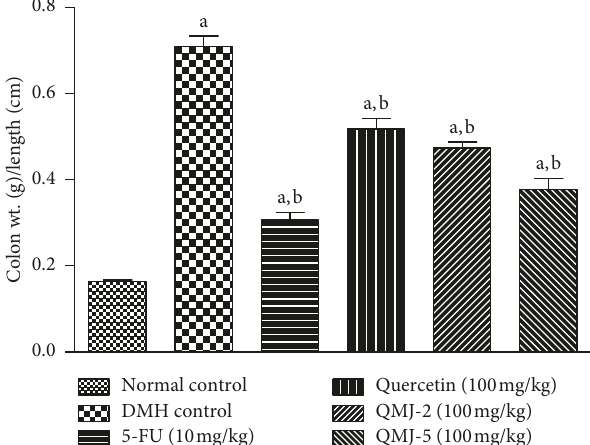
Figure 6: The bar graphs represent colon weight/colon length ratio. All values are expressed as mean ± SEM of six animals. a p < 0 . 05 vs. normal control; b p < 0 . 05 vs. DMH